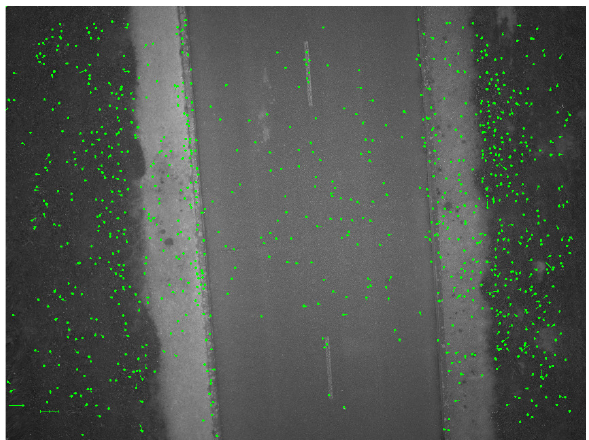
Figure 17. Residus obtained by the 2D homography estimation between the first image and the 10 th image.